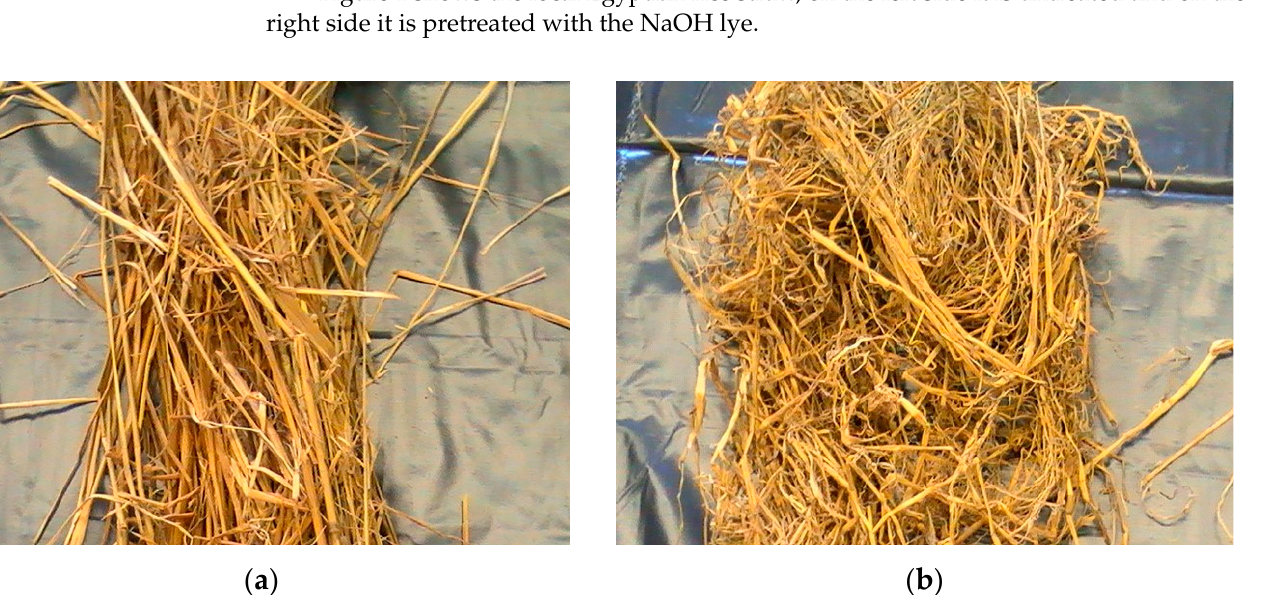
Table 1. Chemical compositions of the binder materials.